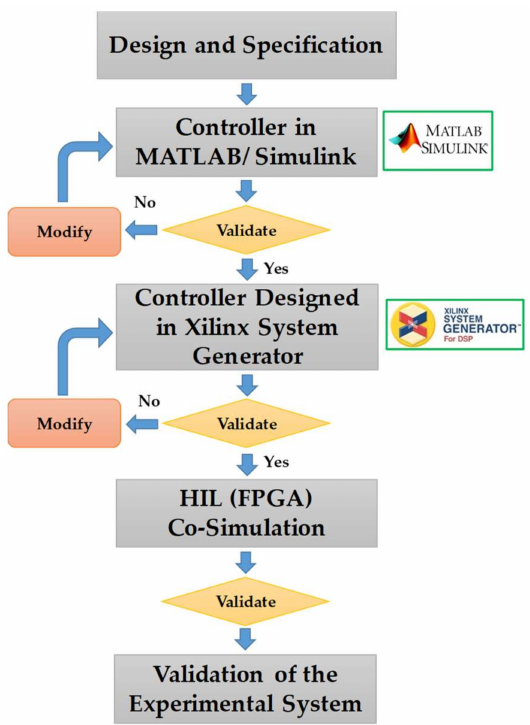
Figure 3. Flowchart of HIL co-simulation using the field-programmable gate array